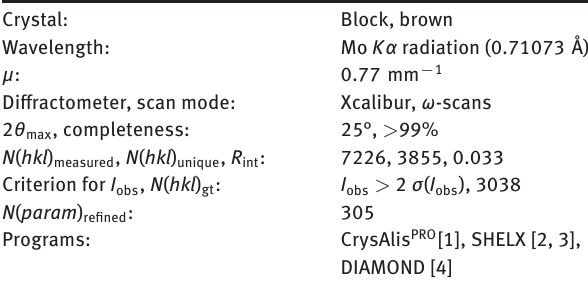
Table 1: Data collection and handling.